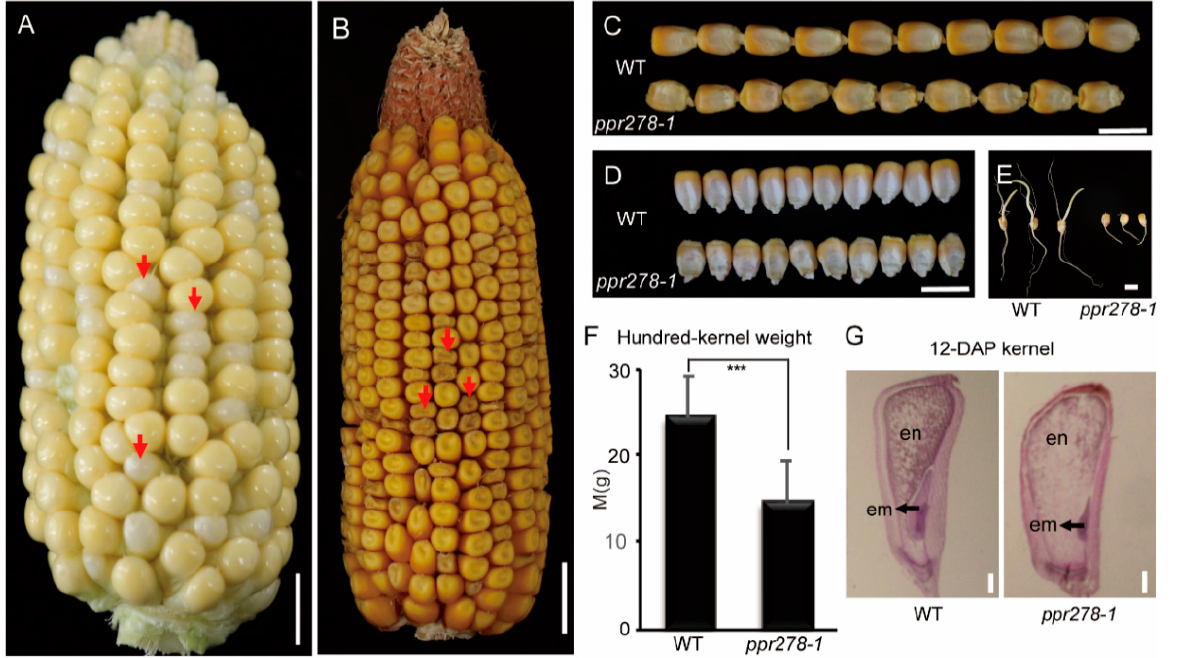
Figure 1. ppr278-1 mutants exhibited defective kernel development and lethal seedlings. ( A , B ) Ears of self-pollinated heterozygous ppr278-1 plants at 16 days after pollination (16 DAP) ( A ) and at maturity ( B ). Red arrows indicate the mutant kernels. Bar = 1 cm. ( C , D ). Comparison of the length ( C ) and width ( D ) of mature seeds of the WT and the ppr278-1 mutant. Bar = 1 cm. ( E ) Germination of WT and ppr278-1 mutant seeds after dark culture for two days in an incubator. Bar = 1 cm. ( F ) Comparison of the 100-kernel weight of fully-mature WT and ppr278-1 mutant kernels. Values and error bars represent the mean and standard deviation of three biological replicates. ***, p < 0.001 ( t -test), representing a significant difference. ( G ) Longitudinal section of WT ( left ) and ppr278-1 mutant kernels ( right ) at 12-DAP. en: endosperm, em: embryo. Bar = 0.5 mm.